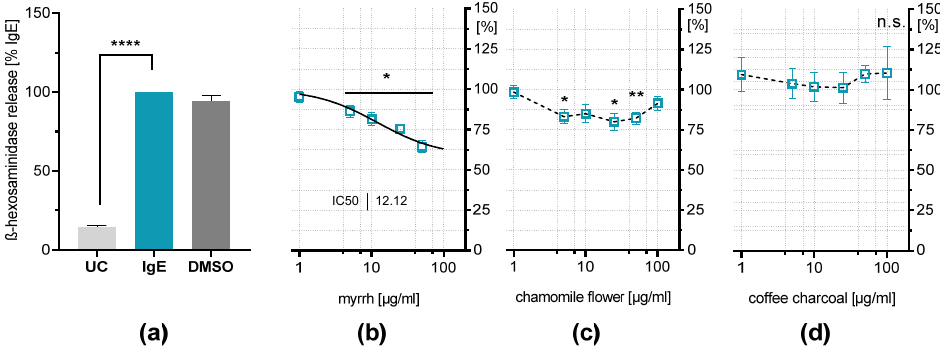
Figure 3. Effects of the plant extracts on β -hexosaminidase release of IgE-stimulated RBL-2H3 cells. β -hexosaminidase release was determined after overnight (18 h) incubation with 500 ng/mL IgE following 30 min stimulation with 1 µg/mL DNP-HSA (IgE = 100%) compared untreated control (UC) and vehicle control (IgE + 0.2% DMSO) ( a ). ( b ) Myrrh resin extract (1–50 µg/mL), ( c ) chamomile flower extract (1–100 µg/mL) or ( d ) coffee charcoal extract (1–100 µg/mL) were incubated simultaneously to IgE. Results are presented as means ± SEM and non-linear regression for myrrh (continuous line); n = 4–10; * p < 0.05; ** p < 0.01; **** p < 0.0001; n.s. non-significant.